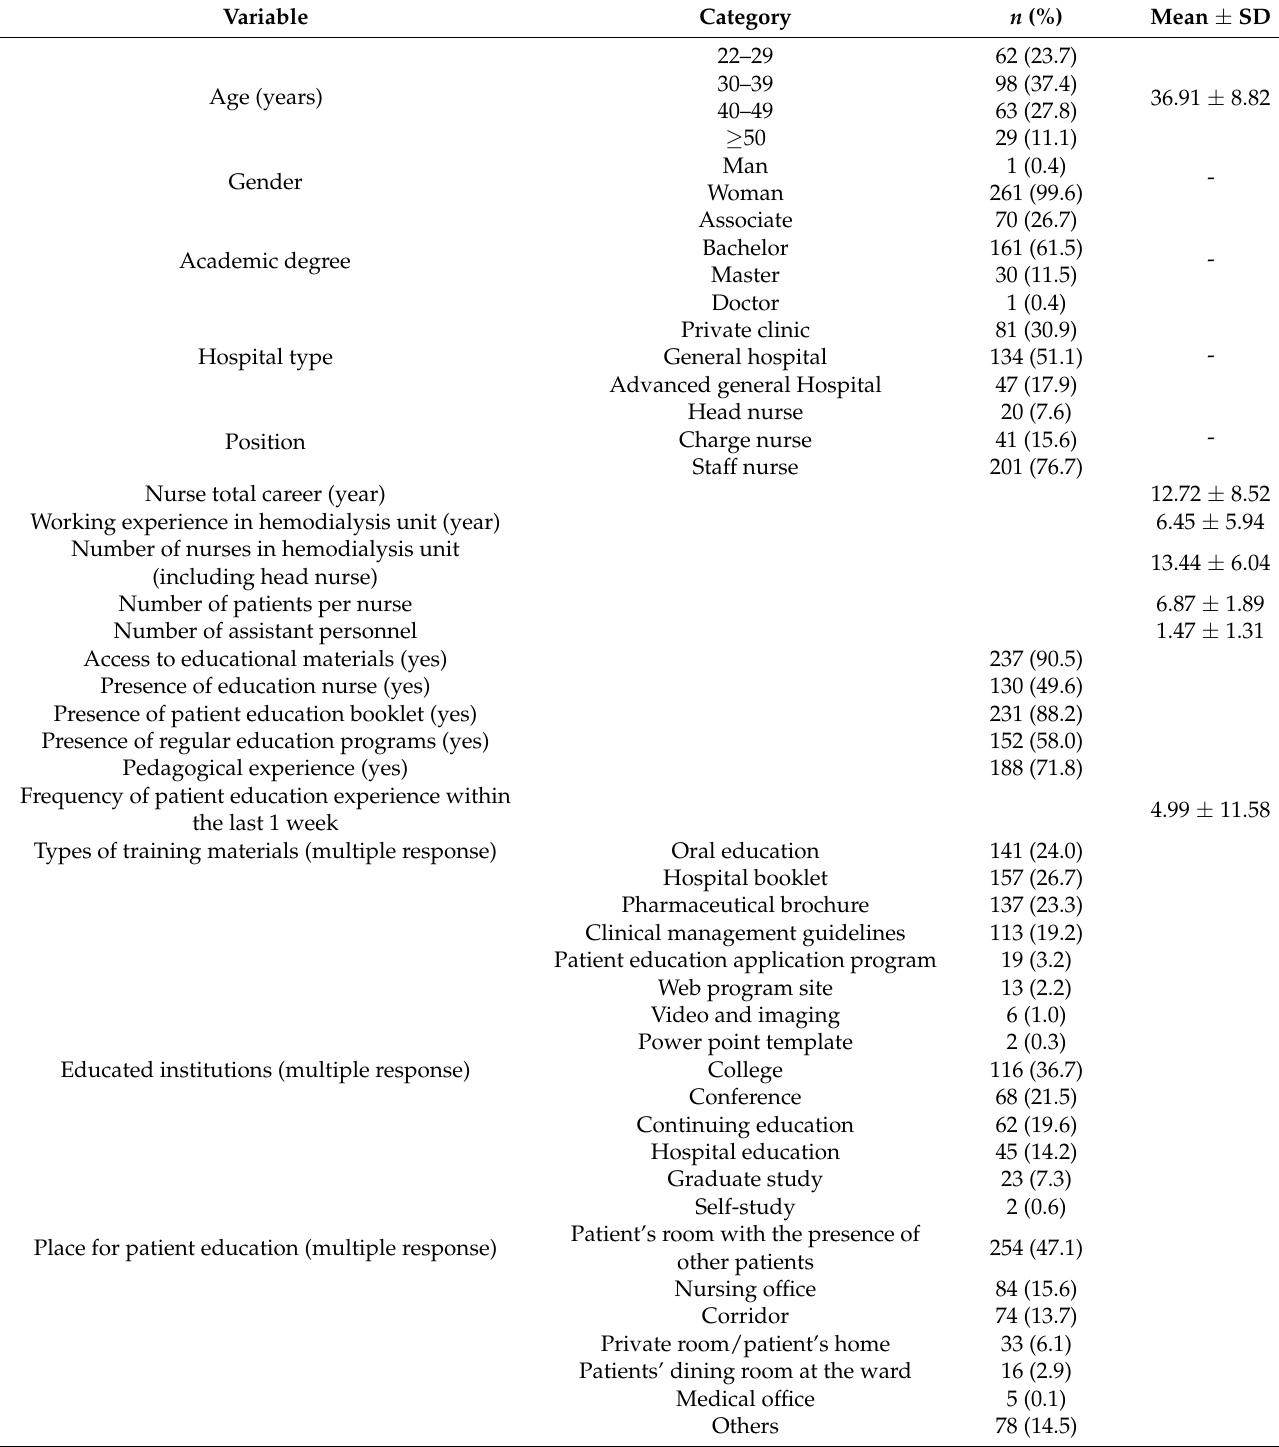
Table 1. General characteristics of nurses ( n =